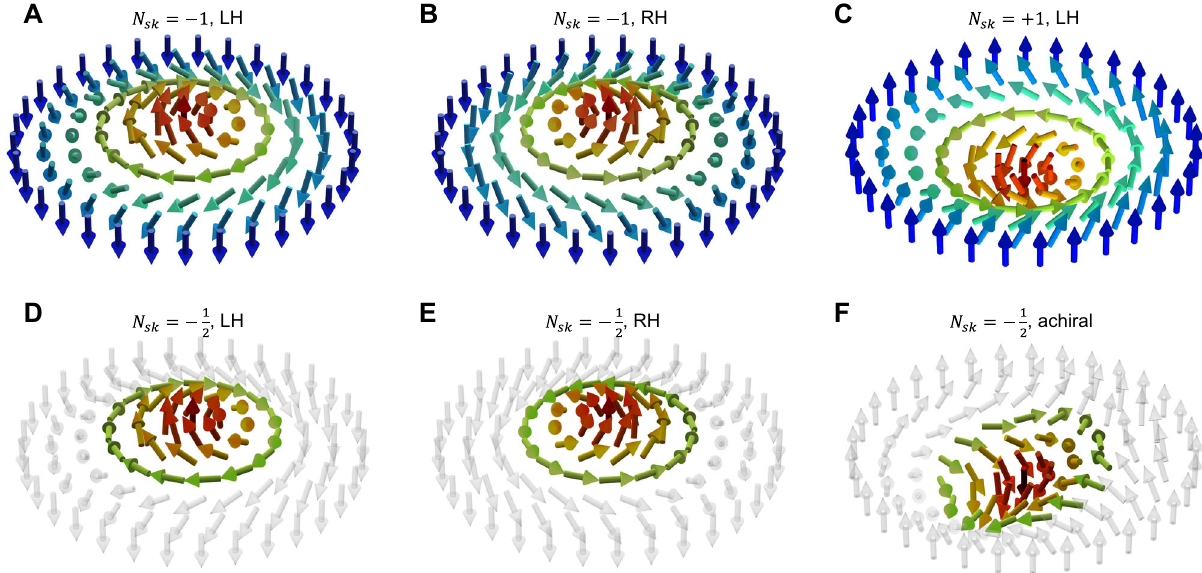
Fig.1|Sketchesofthedipolartexturesobservedformeronsversusskyrmions. Schematic of Bloch-like skyrmions with ( A ) right-handed and ( B ) left-handed chiralities,bothpossessingatopologicalchargeof N Sk = (cid:3) 1.Acommonfeatureof both the Bloch ( ∇ × P ≠ 0, N Sk = (cid:3) 1) and Néel ( ∇ (cid:1) P ≠ 0, N Sk = (cid:3) 1) skyrmions is the out-of-plane polarization rotates from maximal at the core, to maximal in the opposite direction at the periphery. Instead, the meronic phases can be char- acterized by a vanishing out-of-plane polarization atthe periphery, and a non-zero